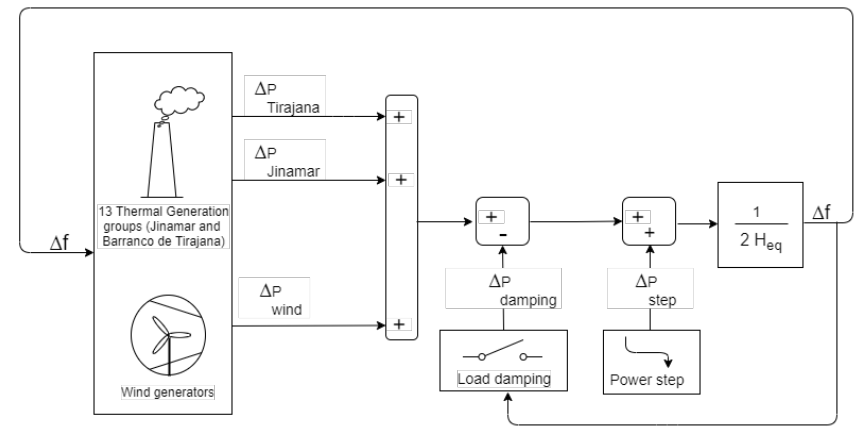
Figure 3. The Gran Canaria power system